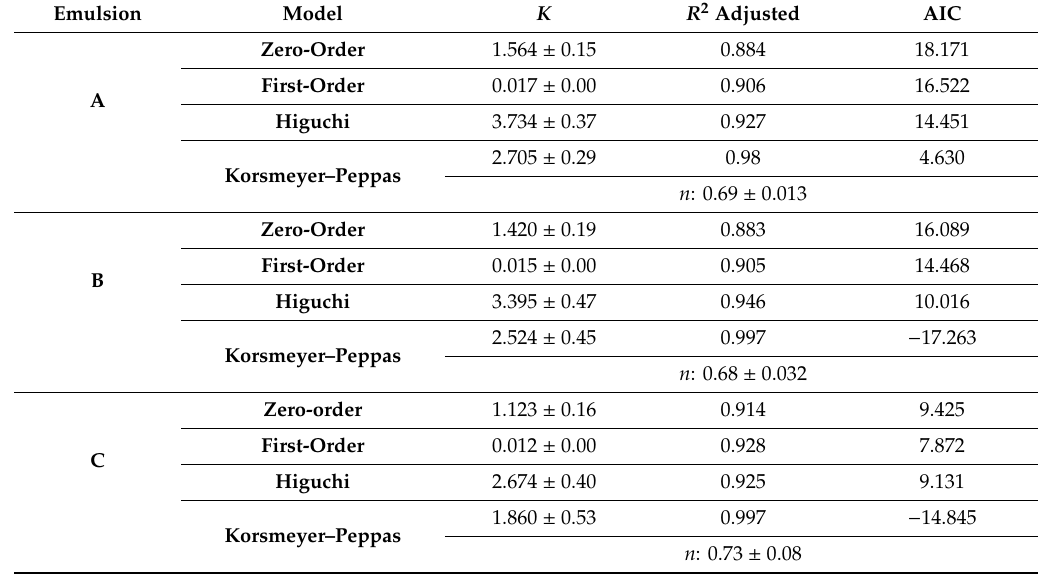
Table 4. Kinetic parameters obtained by fitting the described models to the emulsions release data (mean ± SD, n = 3)